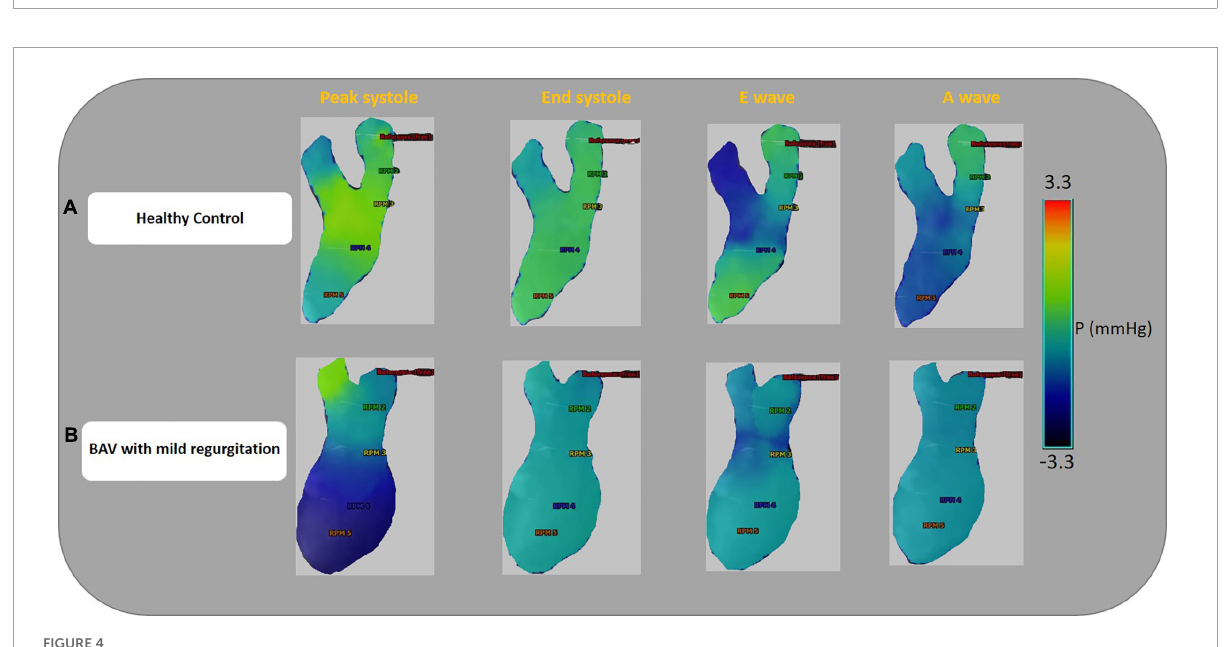
FIGURE4 Ventricular pressure examples. Color-coded pressure pattern of the LA and LV throughout four phases of a cardiac cycle (peak systole, end-systole, E-wave, and A-wave). Both subjects have approximately the same flow with pEF. Panel (A) shows a 46-year-old healthy female and E/A: 1.58. Panel (B) shows a 35.6-year-old BAV patient, male with mild regurgitation and E/A:3.64. The BAV subject shows different local pressure patterns compare to the healthy control. Left atrium (LA), left ventricle (LV), and preserved ejection fraction